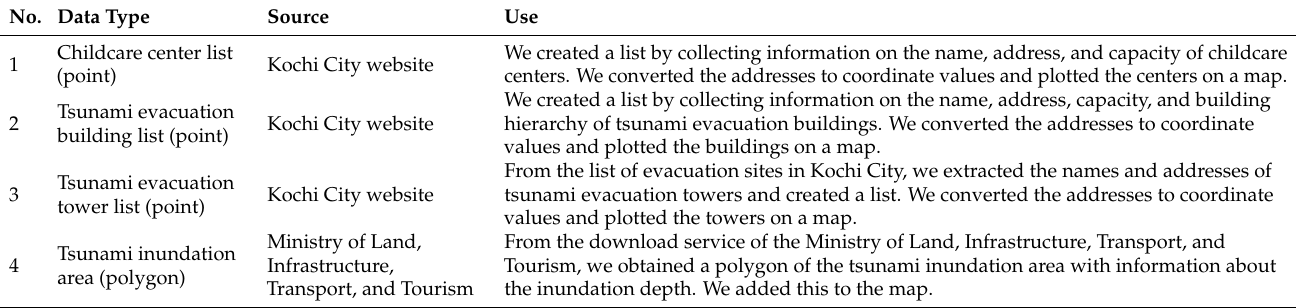
Table 1. The types and sources of data used for analysis.